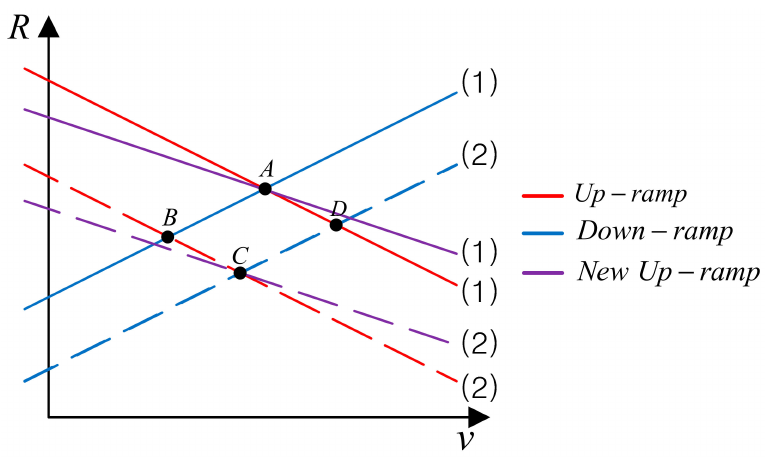
Figure 4. Detection of true target by adding a waveform with different slope.